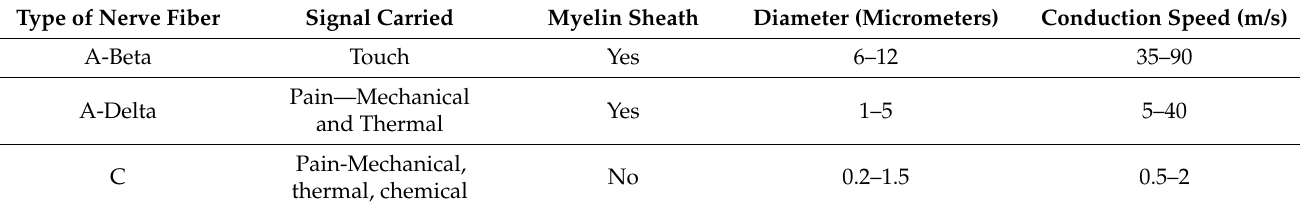
Table 2. Characteristics of Nerve Fibers (Data adapted from Ref.